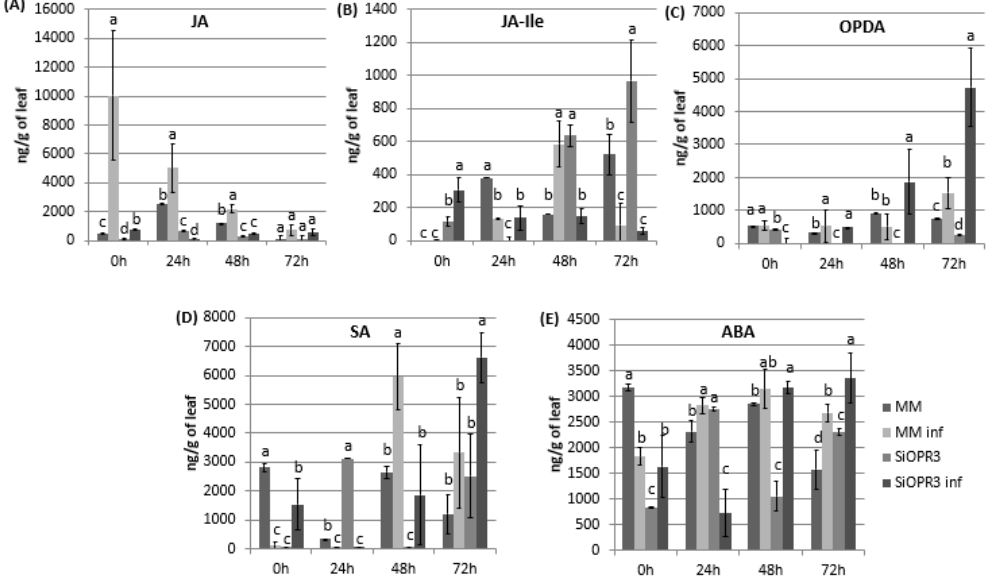
Figure 2. Hormone levels in MM and SiOPR3 plants upon Pst infection. Leaves were collected at 0, 24, 48 and 72 hpi and JA ( A ), JA-Ile ( B ), cis-(+)-12-oxo-phytodienoic acid (OPDA) ( C ), salicylic acid (SA) ( D ), and abscisic acid (ABA) ( E ) levels were determined by ultra-performance liquid chromatography (UPLC)-mass spectrometry. Data show the average of three independent experiments of a pool of 10 plants per experiment ± SE. Different letters indicate statistically significant differences between treatments at the same time point ( p < 0.05; least-significant difference test).